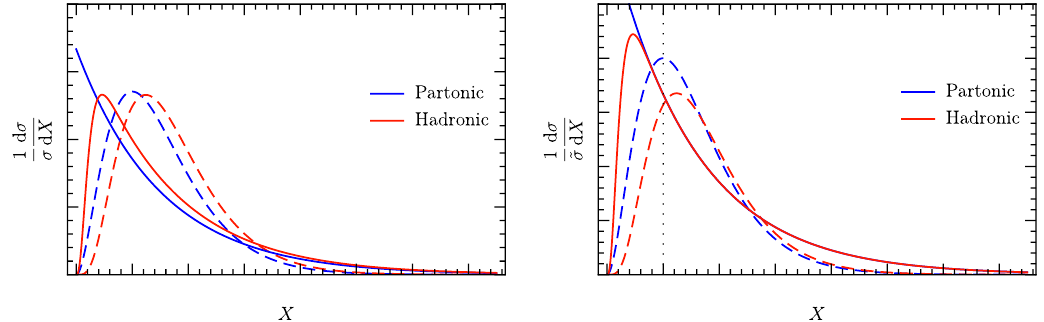
Figure 18 . We explore the effect of hadronization by taking a falling distribution (solid) or a peaked distribution (dashed), as proxy for the perturbative result (blue) of energy drop (for soft drop) and jet mass, and convolving with a shape function to obtain the red curve. While the effects are similar when normalizing on the full range ( 1 /σ , left panel), this is no longer the case when normalizing on the region to the right of the vertical dotted line ( 1 / ˜ σ , right